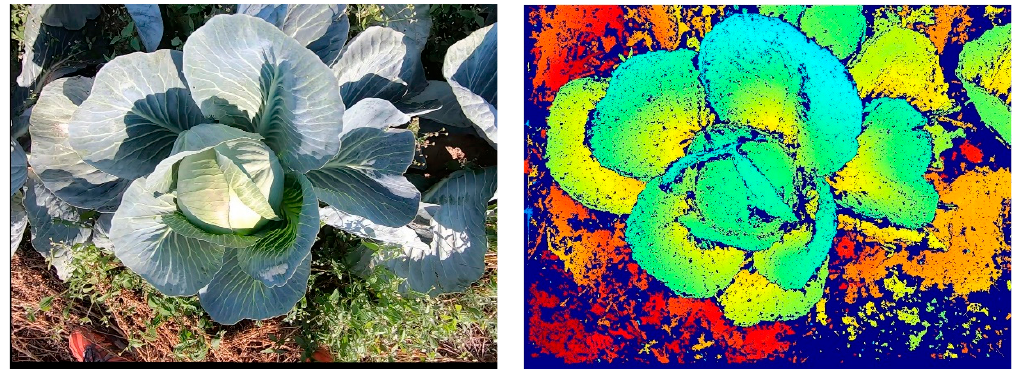
Figure 2 . Example for an RGB image with a corresponding depth image (colored) .